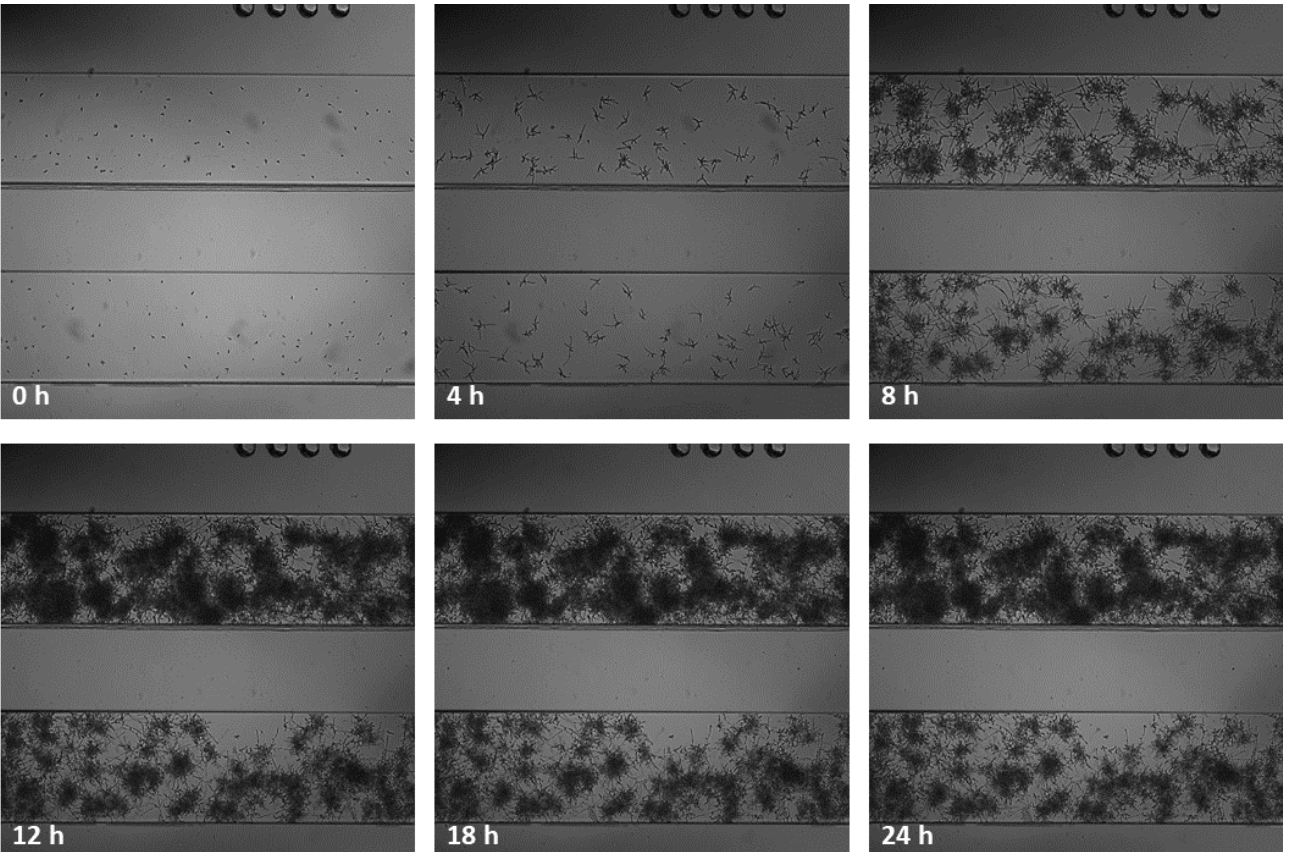
Figure 4. Biofilm formation of C. albicans strain CA1 in two separate channels (biofilm formation phase), in a time-lapse series taking images every 1 h over 24 h of incubation in microfluidic condi- tions with RPMI 1640 medium (without additional compounds), using BioFlux Z1000 system. The presented photographs were taken at the start of the experiment (0 h), and after 4, 8, 12, 18, and 24 h.